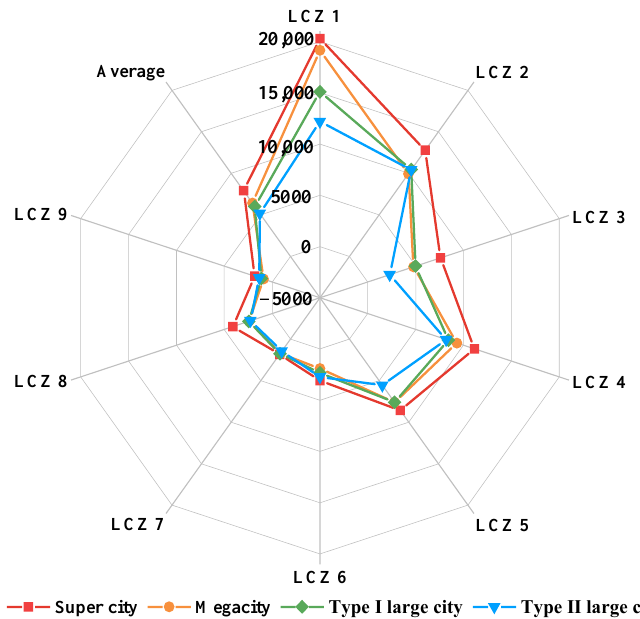
Figure 11. The radar chart of population density of LCZ types for different size cities. (Note: the red box represents supercity, the orange circle represents megacity, the green diamond represents type I large city, and the blue triangle represents type II large city.)